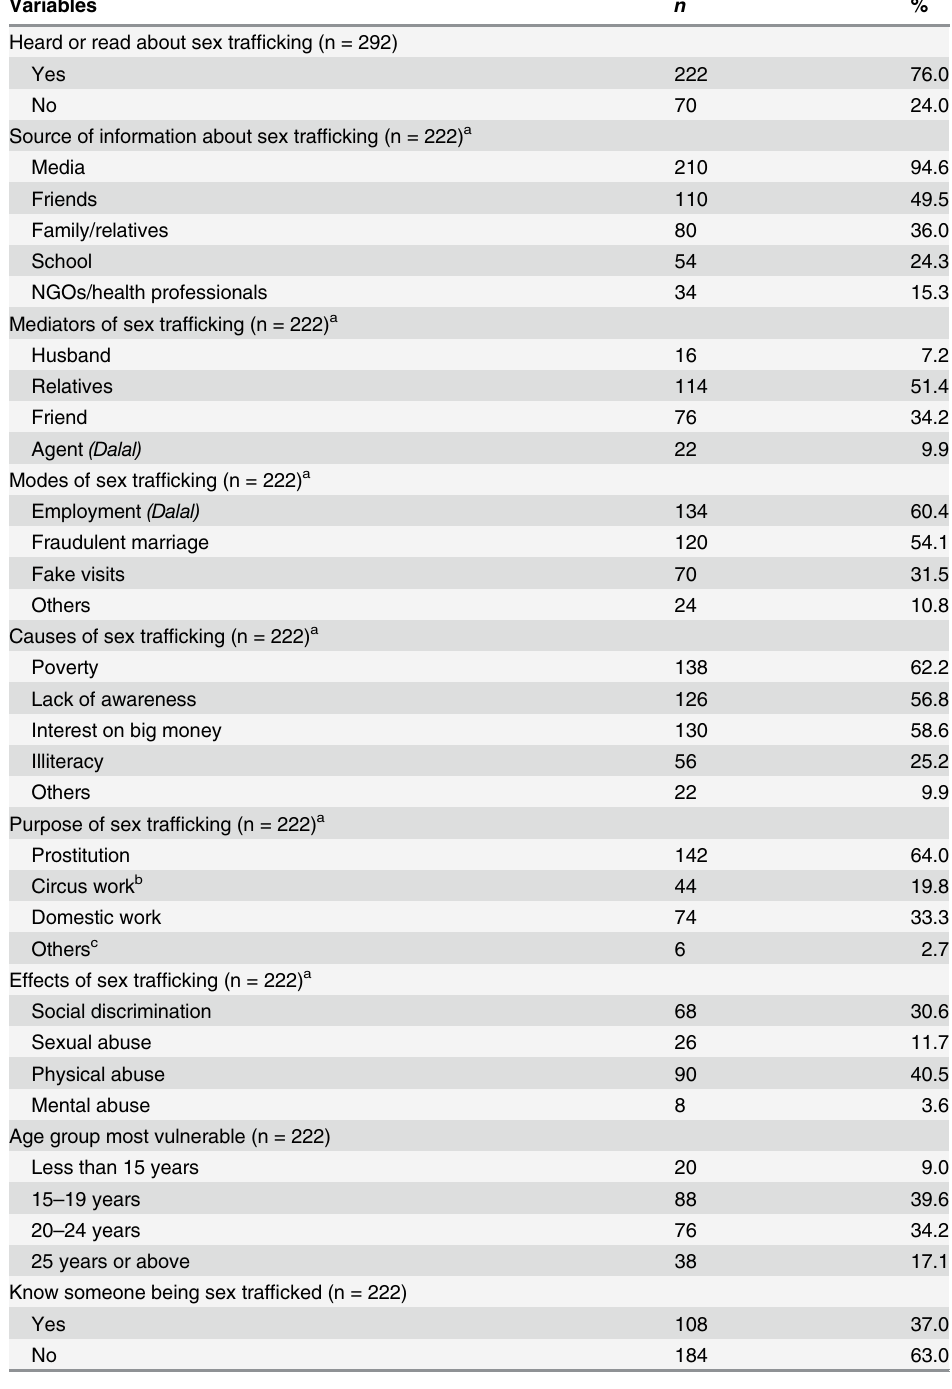
Table 2. Sex trafficking knowledge and awareness among the